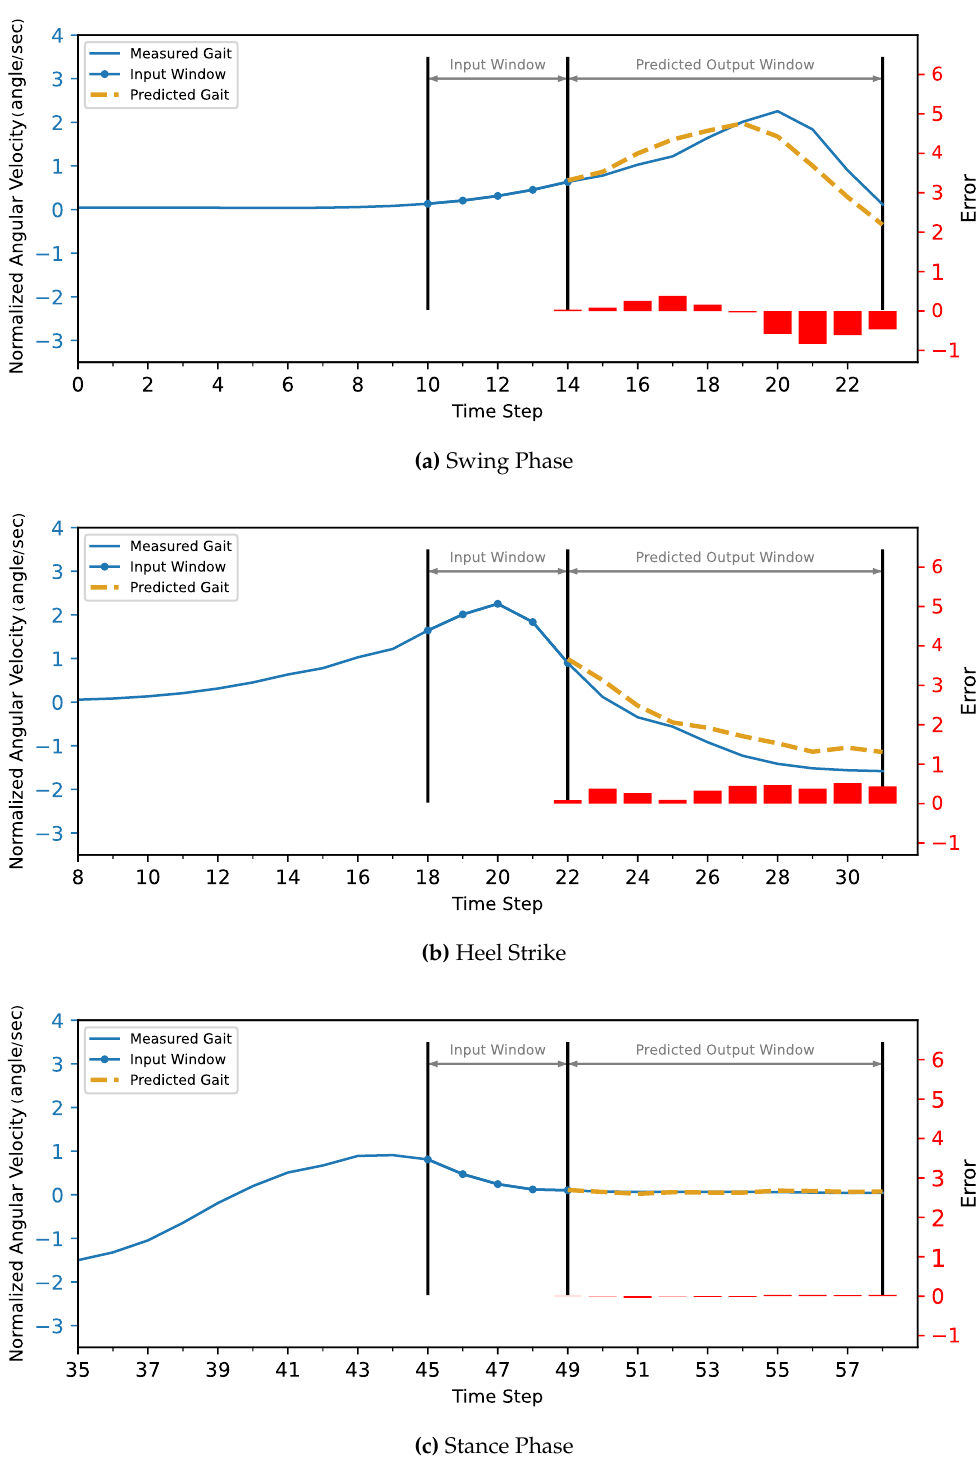
Figure 7. The MLP model without CGP provided 10 time steps ahead prediction for z-score normalized angular velocity of the foot of the inter-subject. The angular velocities are normalized to have zero mean and unit variance. The actual gait is shown in blue, and the predicted trajectory is shown in gold (dashed).